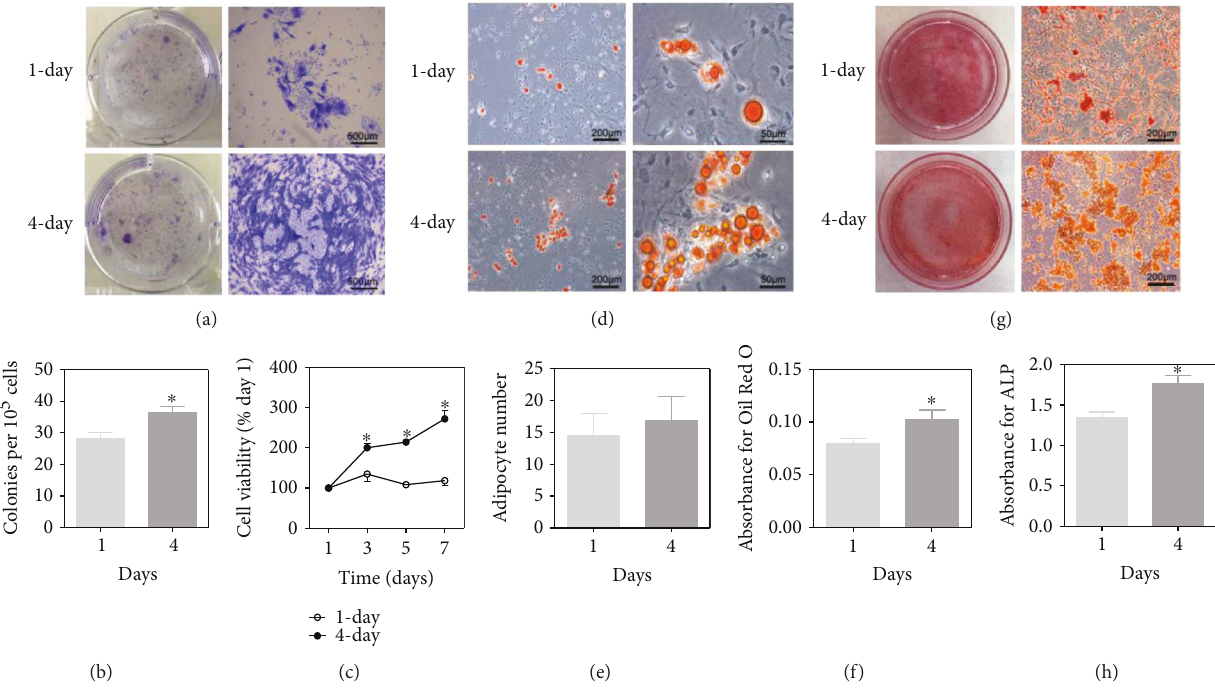
Figure 4: The e ff ect of di ff erent initial medium replacement intervals on proliferation capacity and di ff erentiation potential of BM-MSCs cultured in 5% oxygen condition. (a) Representative image of CFU assay (from left to right, the view from one well of the six-well plate, × 40 with scale bar = 500 μ m). (b) Quanti fi cation of clonogenicity of BM-MSCs by CFU assay. Colonies with an area above 1 mm 2 were counted. (c) Cell viability determined by CCK8 assay. (d) Oil Red O staining after 2 weeks of adipogenic induction (from left to right, × 100 with scale bar =200 μ m and × 400 with scale bar =50 μ m). (e) The number of adipocytes within a microscopic fi eld ( × 100) in 1-day or 4-day medium replacement interval group. (f) Quanti fi cation of Oil Red O staining. (g) Images of Alizarin Red S staining (from left to right, the view from one 35mm dish, × 100 with scale bar =200 μ m). (h) Quanti fi cation of ALP expression. Results are expressed as mean ± SD from three independent measurements. ∗ p < 0 05 versus 1-day